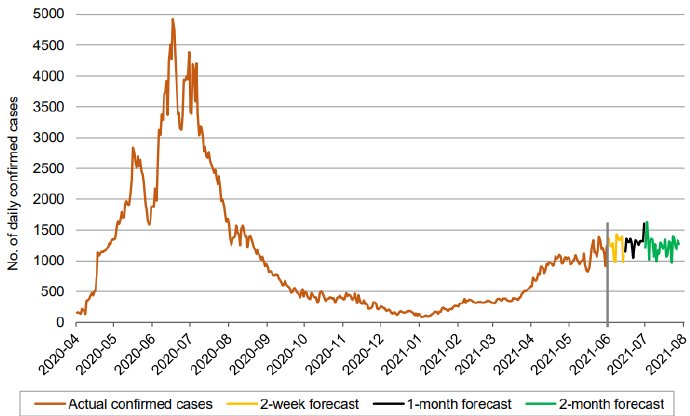
Figure 5. Prediction over a 60-day forecast for the confirmed cases using the LSTM